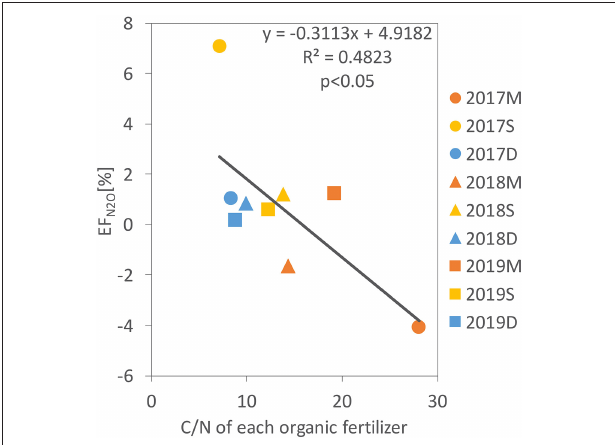
FIGURE 5 | Relationship between N 2 O emission factor and C/N ratio of organic fertilizers. M is the manure plot, S is the slurry plot, and D is the digestive fluid plot. Solid line reveals the result of simple regression analysis.